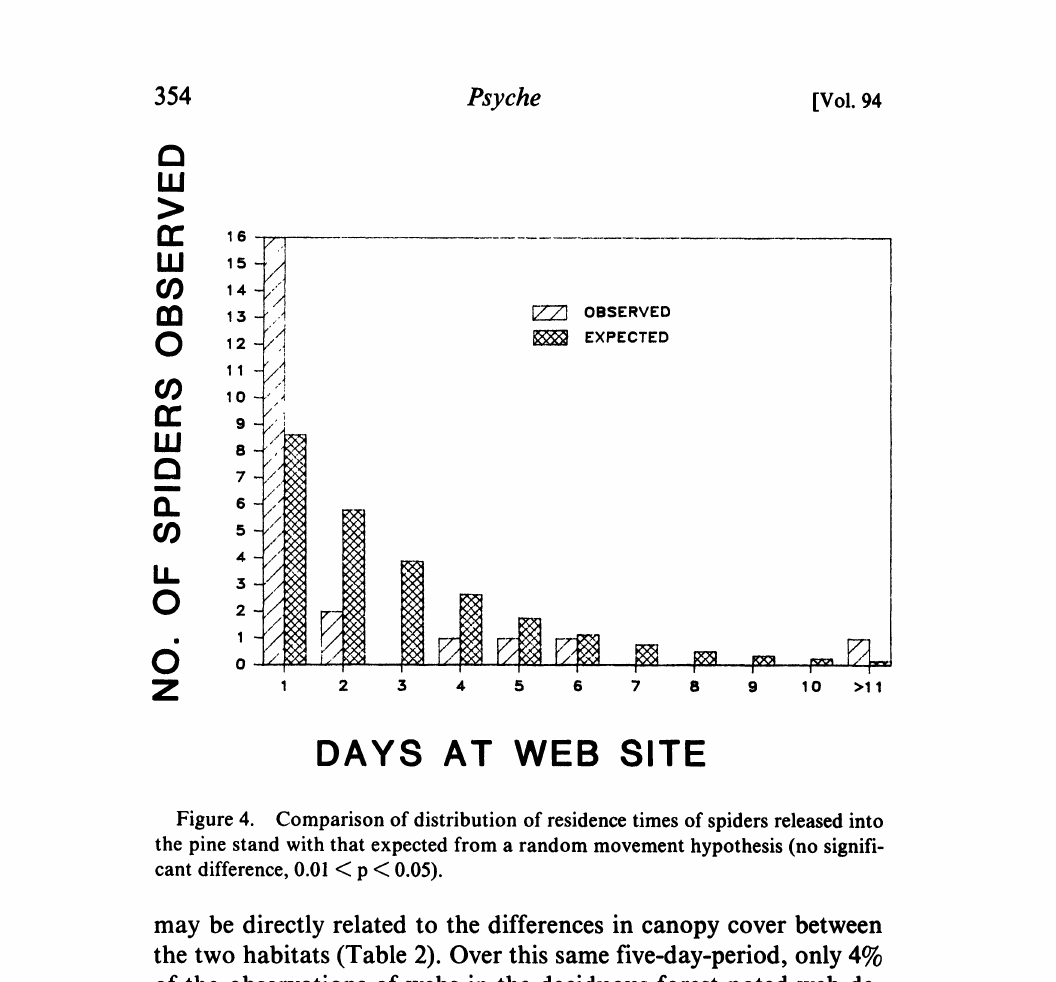
Figure 4. Comparison of distribution of residence times of spiders released into the pine stand with that expected from a random movement hypothesis (no signifi- cant difference, 0.01 < p <